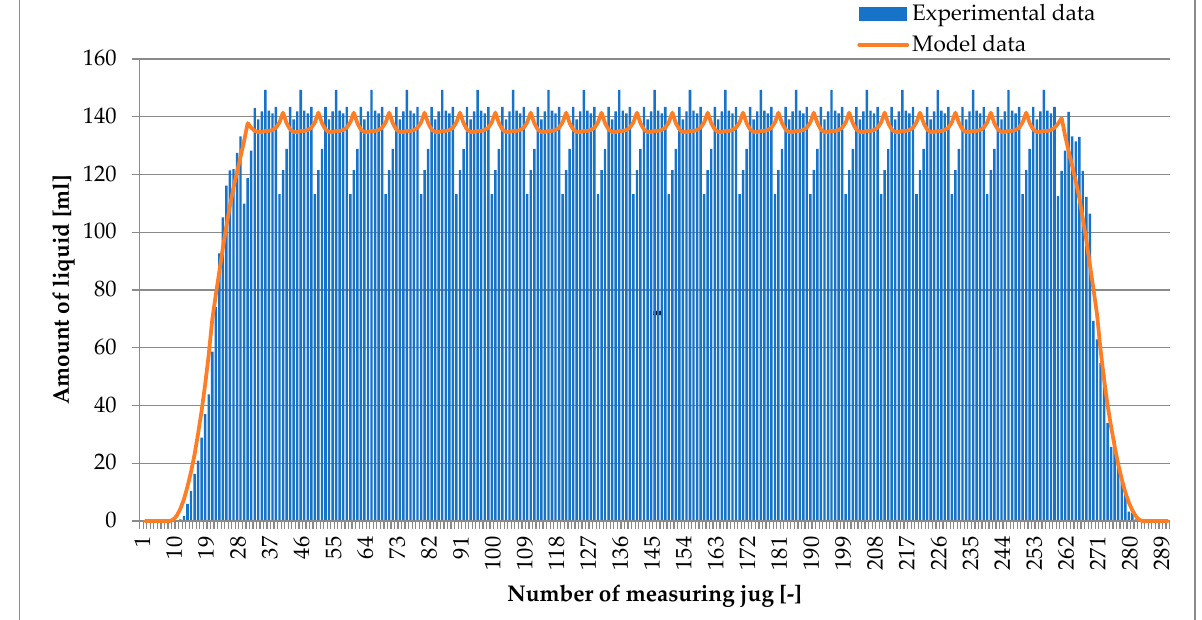
Figure 5. Spray fallout distribution for IDK 120 04 nozzles.